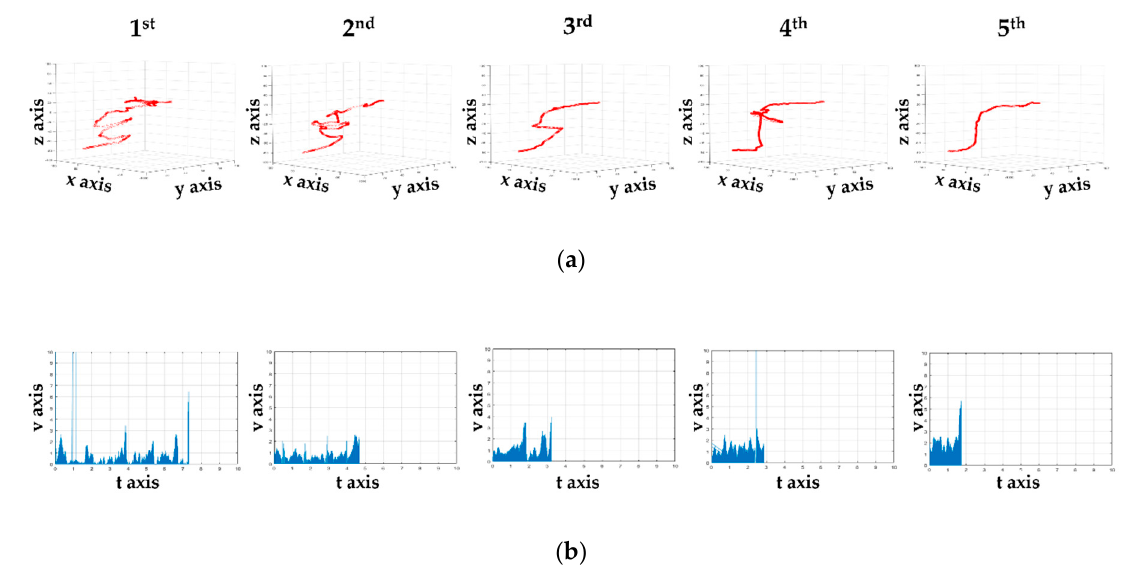
Figure 5. Three-dimensional paths of the probe and sequentially displayed time vector graphs: ( a ) 3D paths of the probes in turn and ( b ) sequentially displayed time vector graphs. The 3D path graphs shows the collision points and movements. The collision and time decrease as the rehabilitation